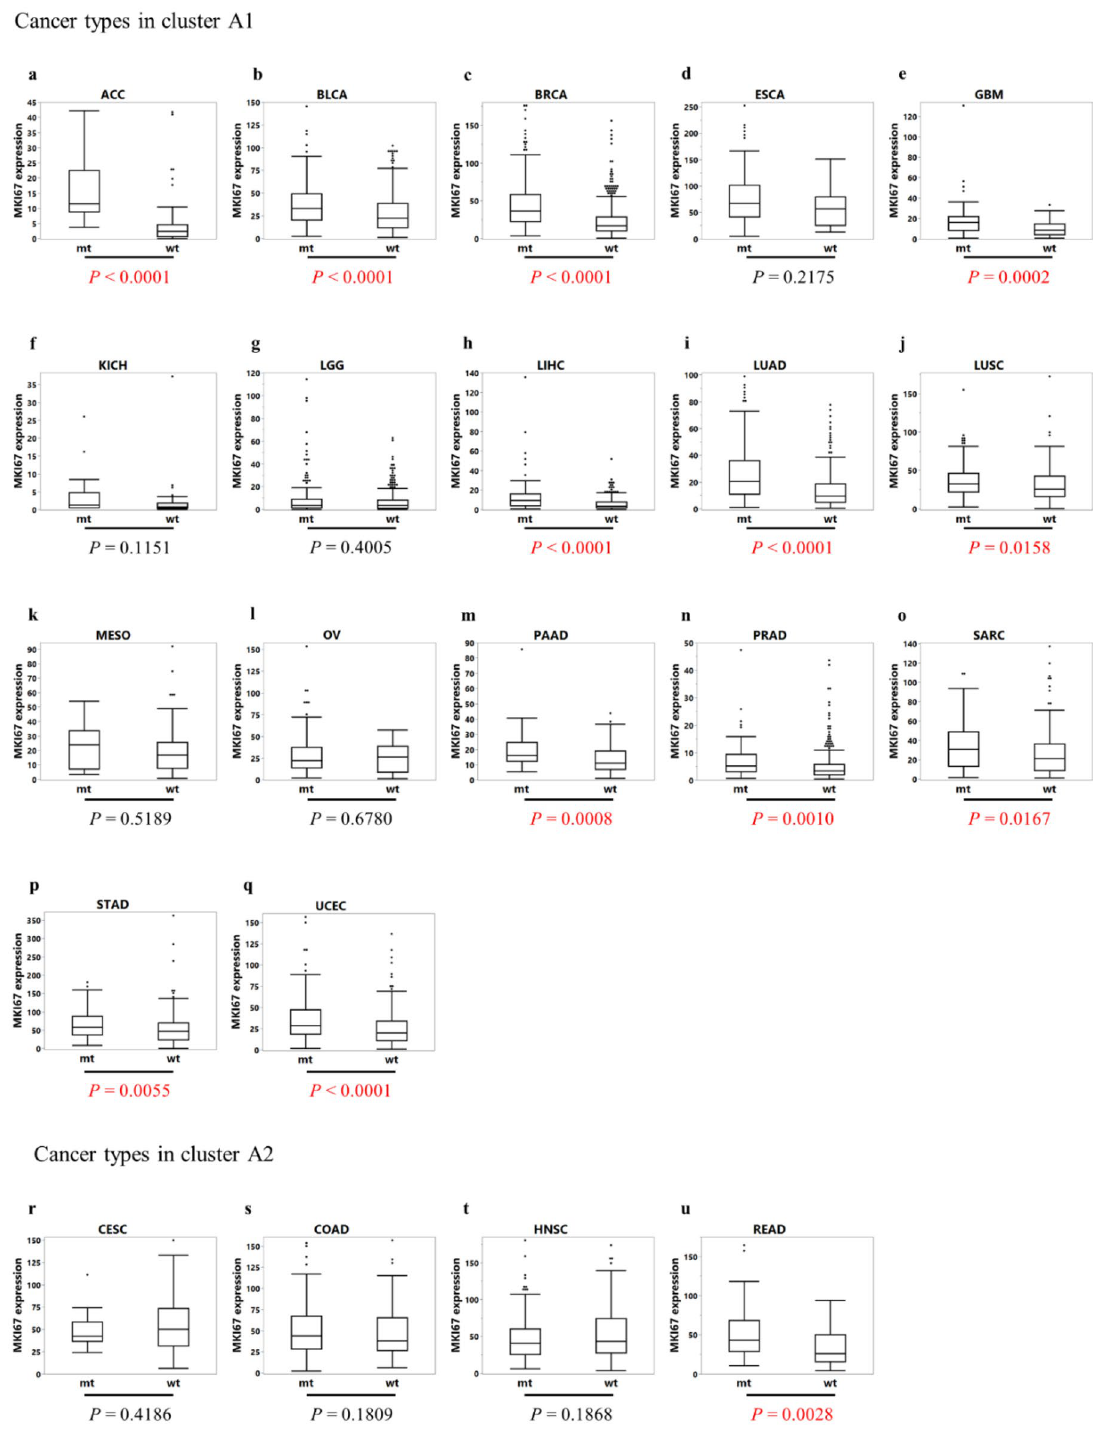
Figure 3. Box plot showing a comparison of the MKI67 expression values between the TP53 mutant and TP53 wild-type groups for each cancer type in cohort A. Each P -value was calculated using the Wilcoxon rank sum test. ( a ) ACC Adrenocortical carcinoma, ( b ) BLCA Bladder urothelial carcinoma, ( c ) BRCA Breast invasive carcinoma; ( d ) ESCA Esophageal carcinoma, ( e ) GBM Glioblastoma multiforme, ( f ) KICH Kidney chromophobe, ( g ) LGG Brain lower grade glioma, ( h ) LIHC Liver hepatocellular carcinoma, ( i ) LUAD Lung adenocarcinoma, ( j ) LUSC Lung squamous cell carcinoma, ( k ) MESO Mesothelioma, ( l ) OV Ovarian serous cystadenocarcinoma, ( m ) PAAD Pancreatic adenocarcinoma, ( n ) PRAD Prostate adenocarcinoma, ( o ) SARC Sarcoma, ( p ) STAD Stomach adenocarcinoma, ( q ) UCEC Uterine corpus endometrial carcinoma, ( r ) CESC Cervical squamous cell carcinoma, ( s ) COAD Colon adenocarcinoma, ( t ) HNSC Head and neck squamous cell carcinoma, ( u ) READ Rectum adenocarcinoma, mt TP53 mutant group, wt TP53 wild-type